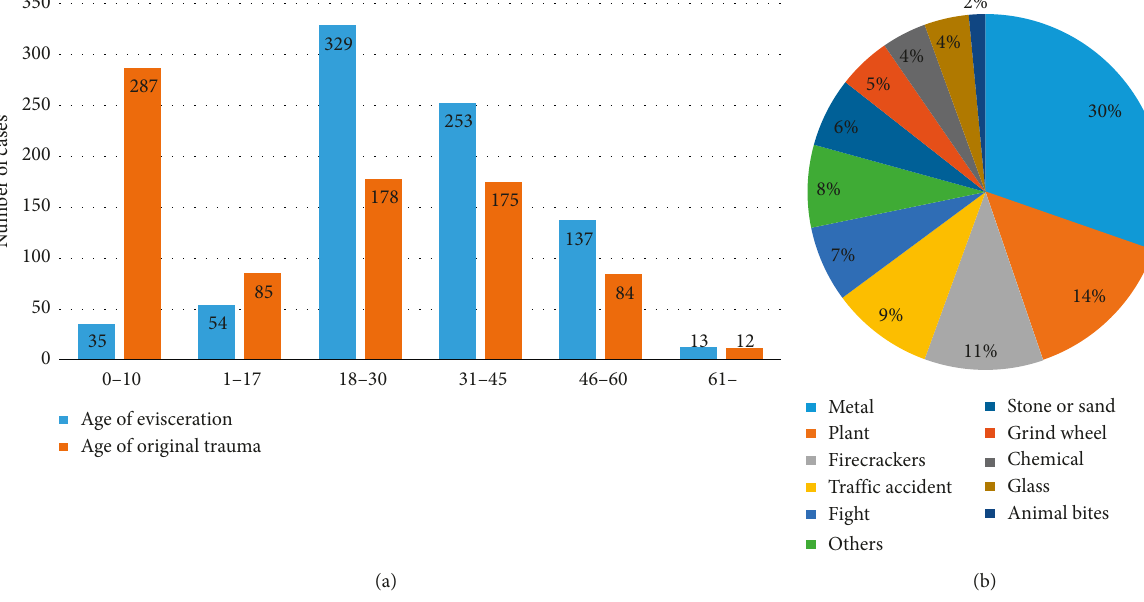
Figure 2: Analysis of the age distribution of the study population and of objects that caused their injury. (a) Most patients underwent evisceration when they were aged between 18 and 30 years, followed by the 31 to 45 years age-group; 89% of the patients who underwent evisceration were adults. However, when considering the age of the patient at the time of the original ocular trauma, most patients were under ten years old (35%), followed by 18–30 and 31–45 years old. (b) The materials of the objects that caused ocular trauma were mostly metal (25%), followed by wood materials (12%). Individual items that caused trauma included fireworks (11%) and grinding wheel